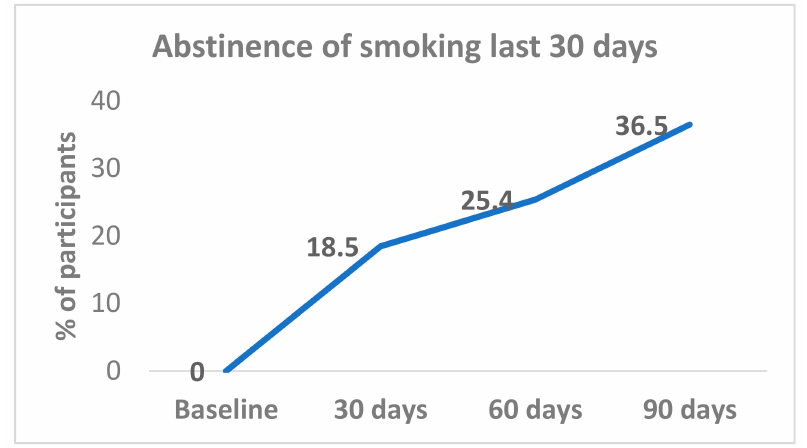
Figure 1. Past 30 days smoking abstinence